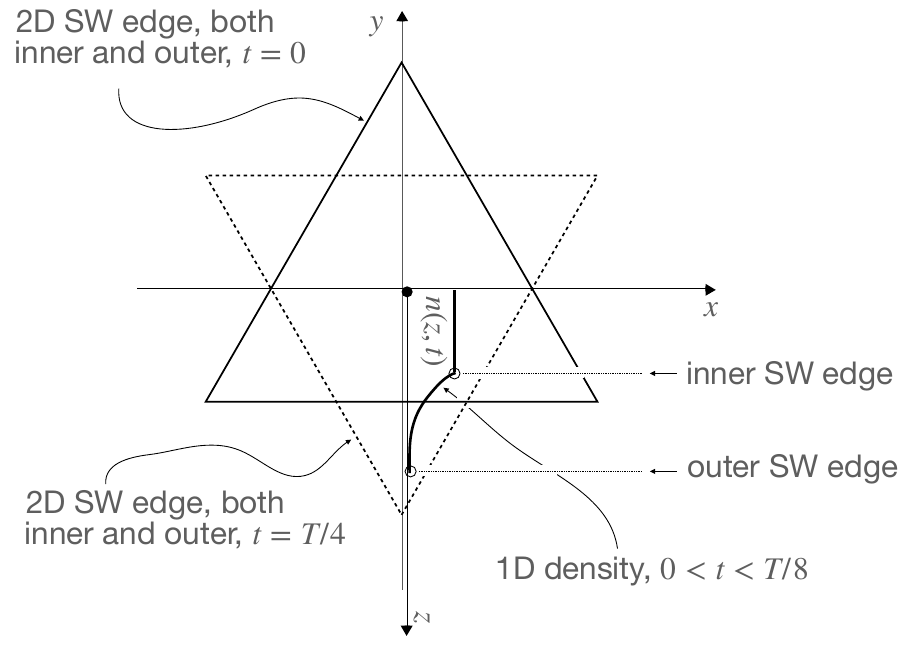
Figure 1: The geometry of the problem. We show both the initial corral (solid line) and its upside-down revival at t = T (dashed line), as well as the density 4 along the down-vertical ray ( x = 0, y ≡ − z < 0 ) , as obtained from the proposed one-dimensional theory. The one-dimensional theory describes a free-propagating Damski-Chandrasekhar shock wave (SW), controllably distorted by the harmonic confinement. At t = T / 8, the bulk portion of the density distribution disappears and the one-dimensional theory stops being